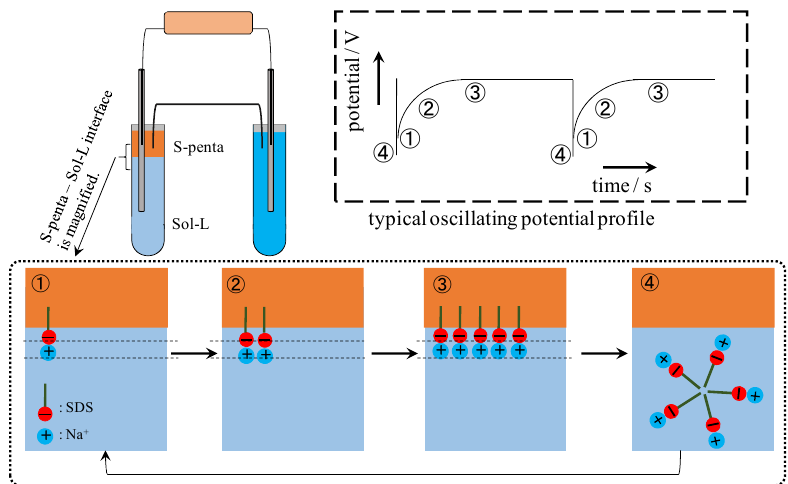
Figure 12. Typical potential profile between 0.3 M NaCl and 0.5 M KCl solutions separated by a silver wire & S ‐ penta is illustrated in the dashed square and the molecular level mechanism of potential oscillation induced at the interface between S ‐ septa and Sol ‐ L is illustrated in dotted square.